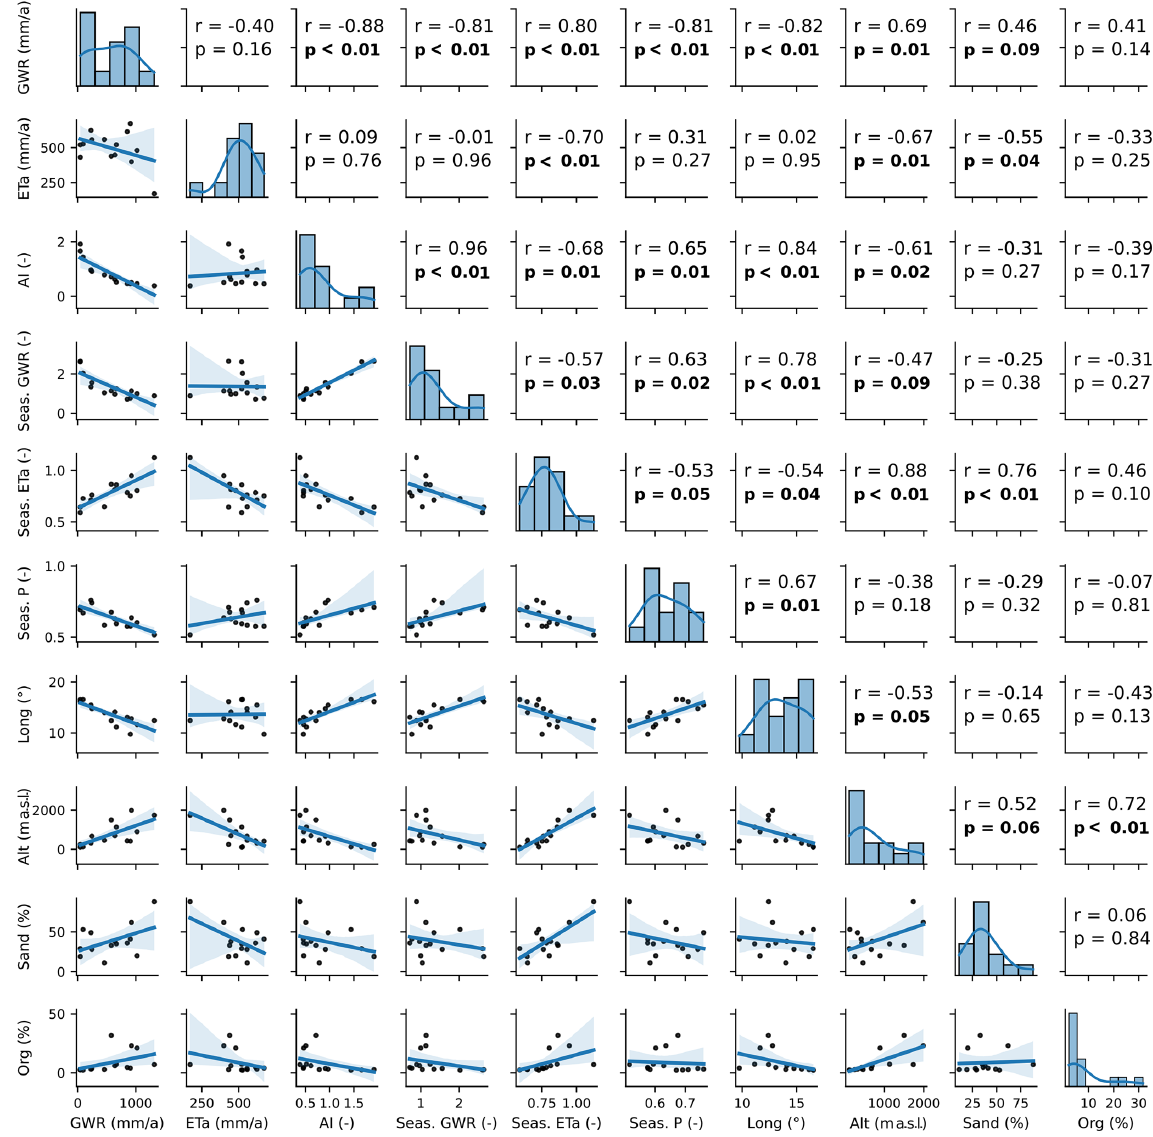
Figure 9. Correlation analysis with pair-wise scatterplots, showing Spearman’s ρ correlation coefficient and significance levels for the following variables at the 14 monitoring sites: potential annual groundwater recharge (GWR); annual actual evapotranspiration (ET a ); the aridity index (AI); seasonalities (Seas.) in GWR, ET a , and P ; longitude (Long); altitude (Alt); and the percentages of sand and organic matter